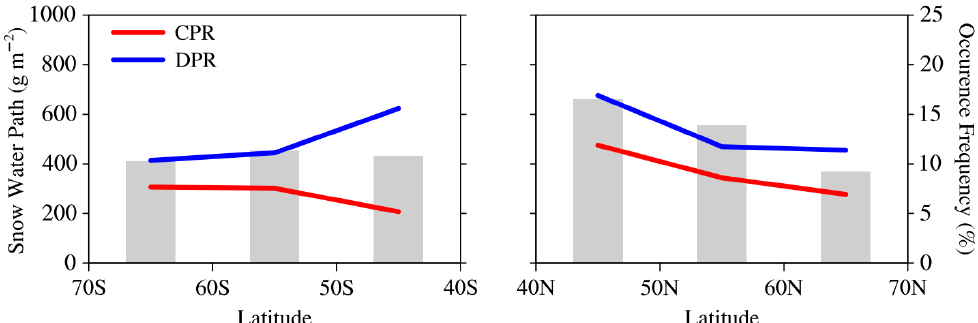
Figure 10. Zonally mean snow water paths (line) and their occurrence frequencies (bar) for CPR and DPR in 10° latitude band over oceans under the condition that both CPR and DPR detect the falling snow.